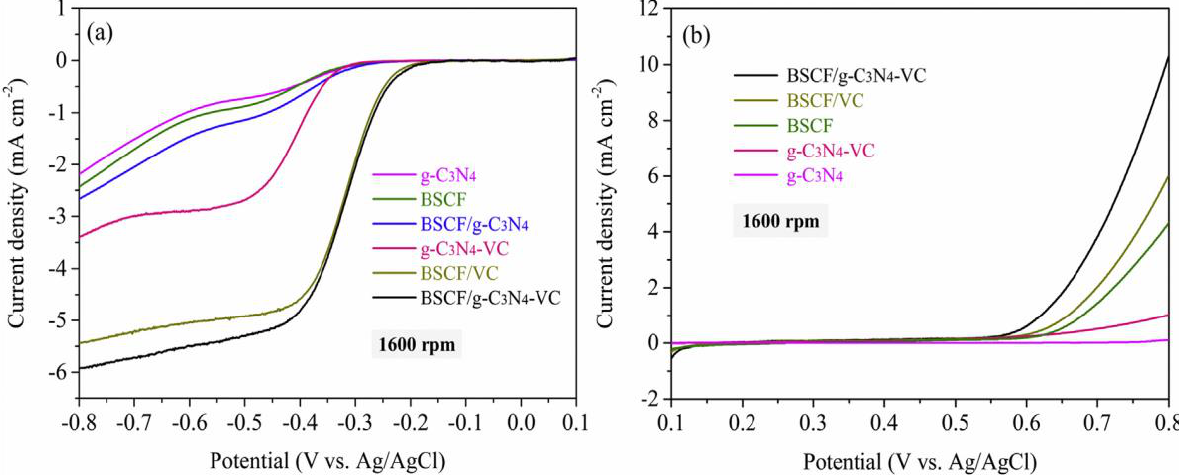
Figure 13. ( a ) ORR catalytic activities of g–C 3 N 4 , BSCF, BSCF/g–C 3 N 4 , g–C 3 N 4 –VC, BSCF/VC and BSCF/g–C 3 N 4 –VC ( b ) and OER catalytic activities of g–C 3 N 4 , BSCF, g–C 3 N 4 –VC, BSCF/VC and BSCF/g–C 3 N 4 –VC measured by LSV at a rotating rate of 1600 rpm in O 2 -saturated 0.1 M KOH solution at a scan rate of 5 mV s −1 . Copyright 2020 by the Elsevier [12].